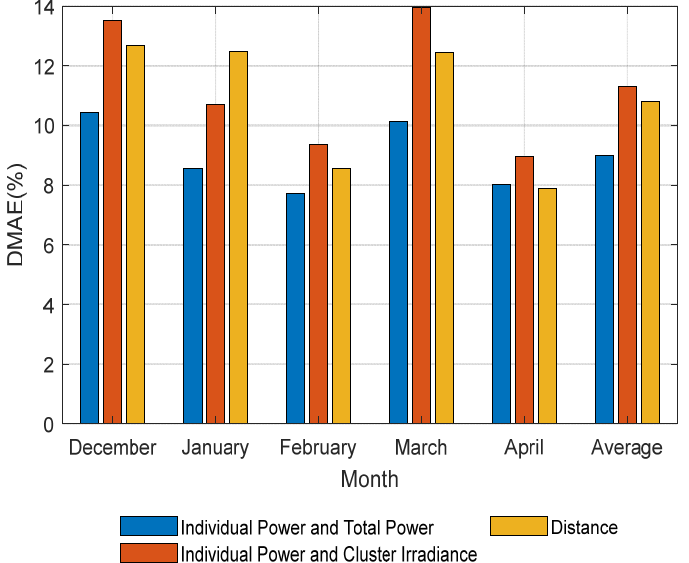
Figure 7. The results of selecting the representative PV plants using different factors.